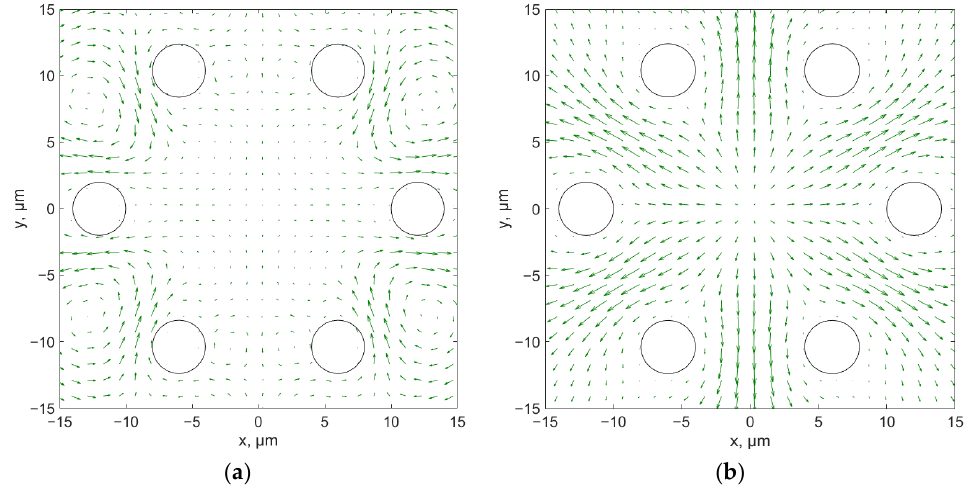
Figure 9. Spin ( a ) and orbital ( b ) parts of the transverse component of the Poynting vector of the fundamental core mode of an HF with the same geometric parameters as for the ASBGF at a loss minimum (Figure 4) in the case of linear polarization. The calculation was carried out at a wavelength of 1 µ m.